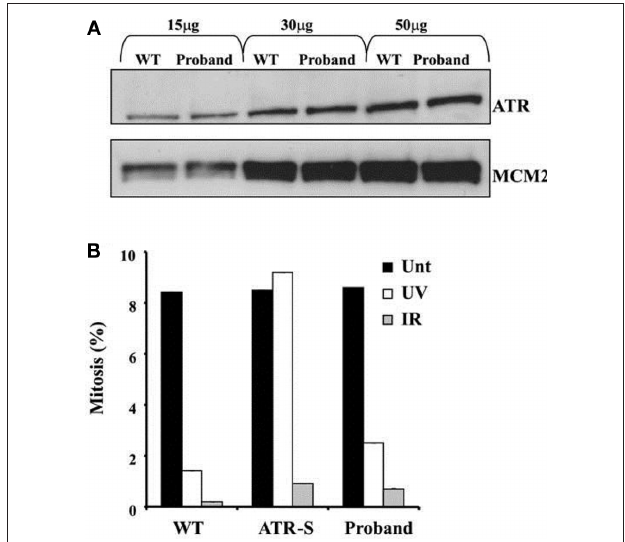
FiguRE 4 | (A) ATR protein expression in EBV-transformed lymphoblastoid cells from the proband compared to a wildtype control (WT). MCM2 is shown as a loading control. (B) Preserved G2-M cell cycle checkpoint in response to either ultraviolet light (UV) or ionizing radiation (IR), assessed by the rate of mitosis compared to untreated cells (Unt). Cells from a patient with biallelic hypomorphic mutation of ATR (ATR-S) are shown as a positive control for ATR